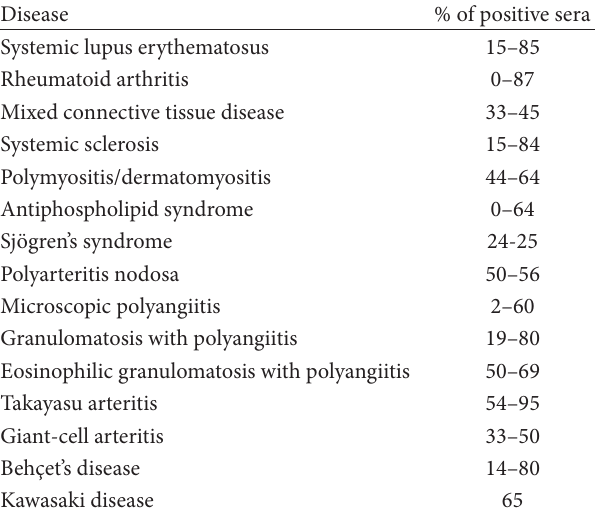
T 1: Prevalence of anti-endothelial cell